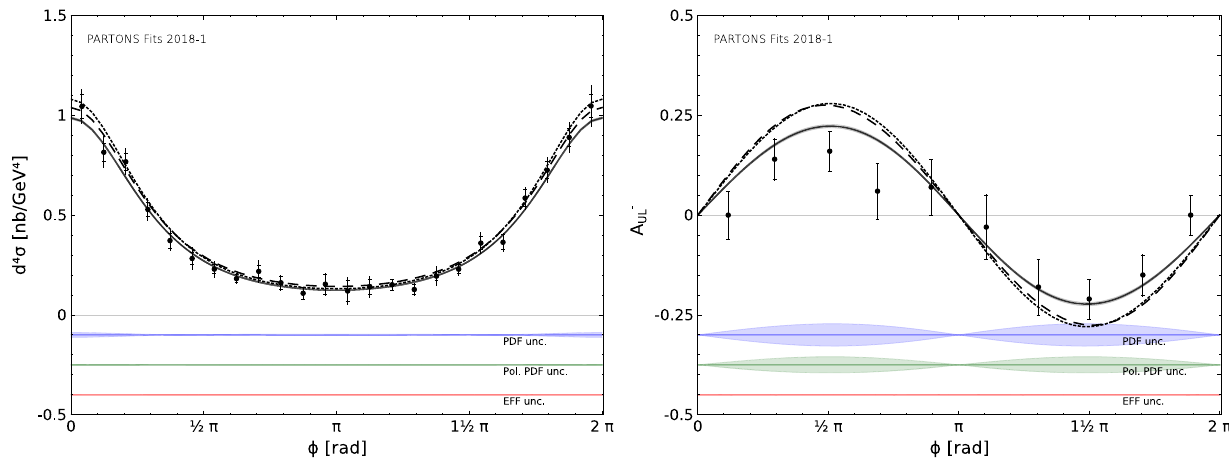
Fig. 6 Comparison between the results of this analysis, some selected and EFFs, can be separately estimated from the bands located below the curves and labeled with “PDF unc.”, “Pol. PDF unc.” and “EFF GPD models and experimental data published by CLAS in Refs. unc.”, respectively. Each of those four uncertainties is evaluated in the [128,129] for d 4 σ − at x Bj = 0 . 244, t = − 0 . 15 GeV 2 and Q 2 = UU analysis of the corresponding set of replicas. The inner bars on data 1 . 79 GeV 2 (left) and for A − at x Bj = 0 . 2569, t = − 0 . 23 GeV 2 , UL points are for statistical uncertainties, while those outer ones are for Q 2 = 2 . 019 GeV 2 (right). The solid curves and the gray bands sur- the quadratic sum of statistical and systematic uncertainties. The dot- rounding those curves correspond to the results of this analysis and ted curve is for the GK GPD model [73–75], while the dashed one is 68% confidence levels for the uncertainties coming from DVCS data, for VGG [76,78–80]. The curves are evaluated at the kinematics of respectively. The magnitudes of the additional uncertainties to the plot- experimental data ted observables and coming from unpolarized PDFs, polarized PDFs